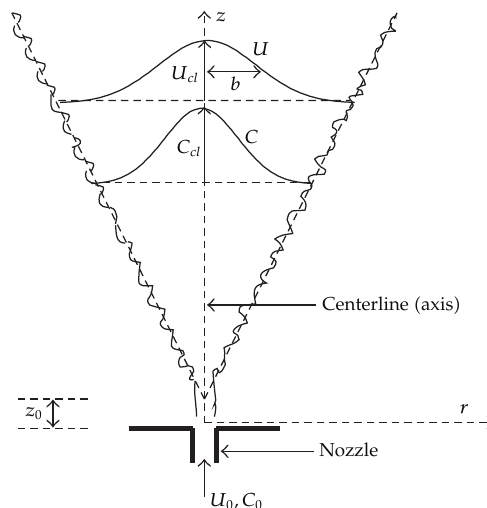
Figure 1: Schematic diagram of turbulent hydrogen - air